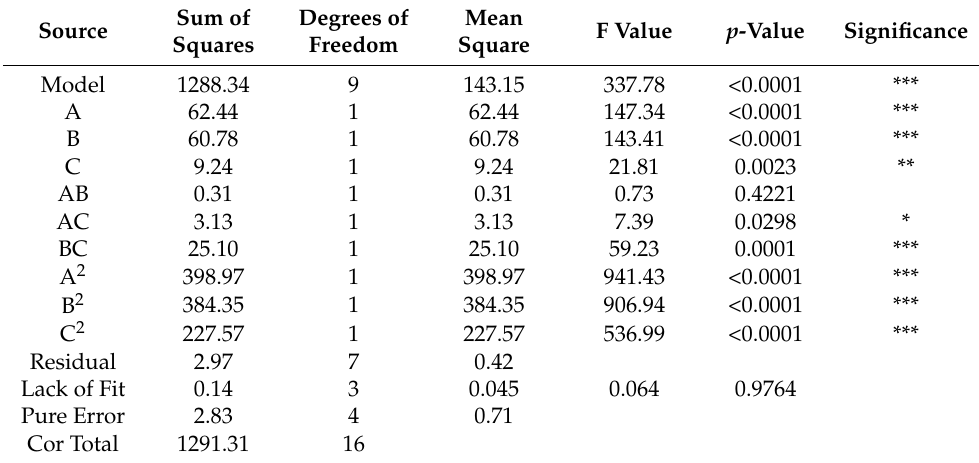
Table 3. Analysis of